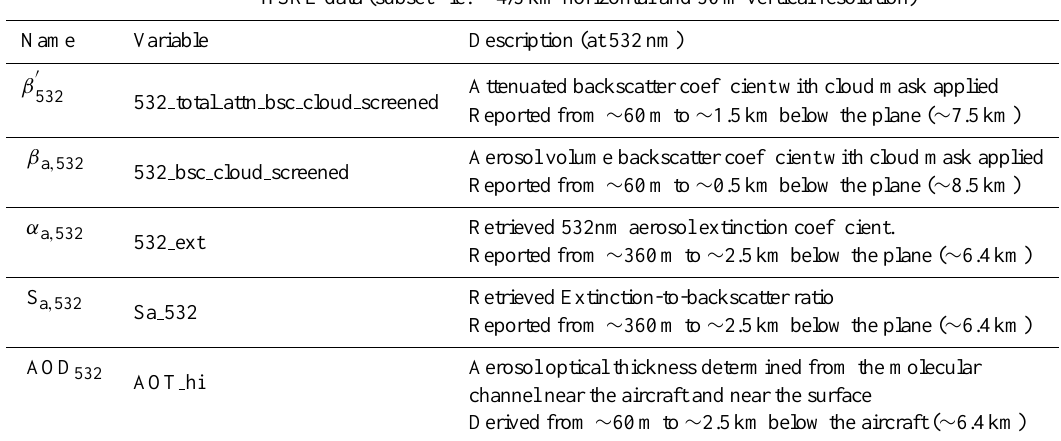
Table 2. HSRL parameters used in this study with attributed name, variable and short description. HSRL data (subset file: ∼ 4/3km horizontal and 30m vertical